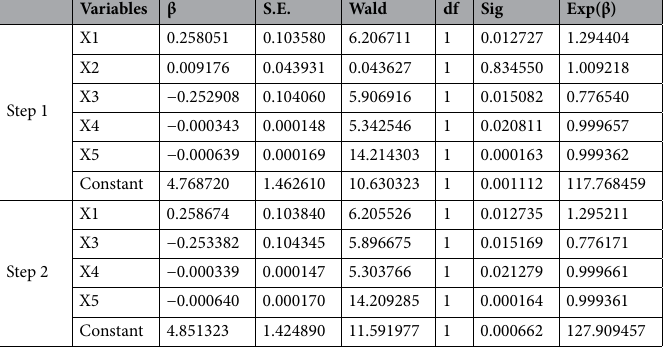
Table 3. Predictive model parameters of beacon sites. β regression coefficient. S.E. standard error, Wald value used to test whether the independent variable has an impact on the dependent variable, df degree of freedom, Sig. significance level, Exp(β) odds ratio 32 .